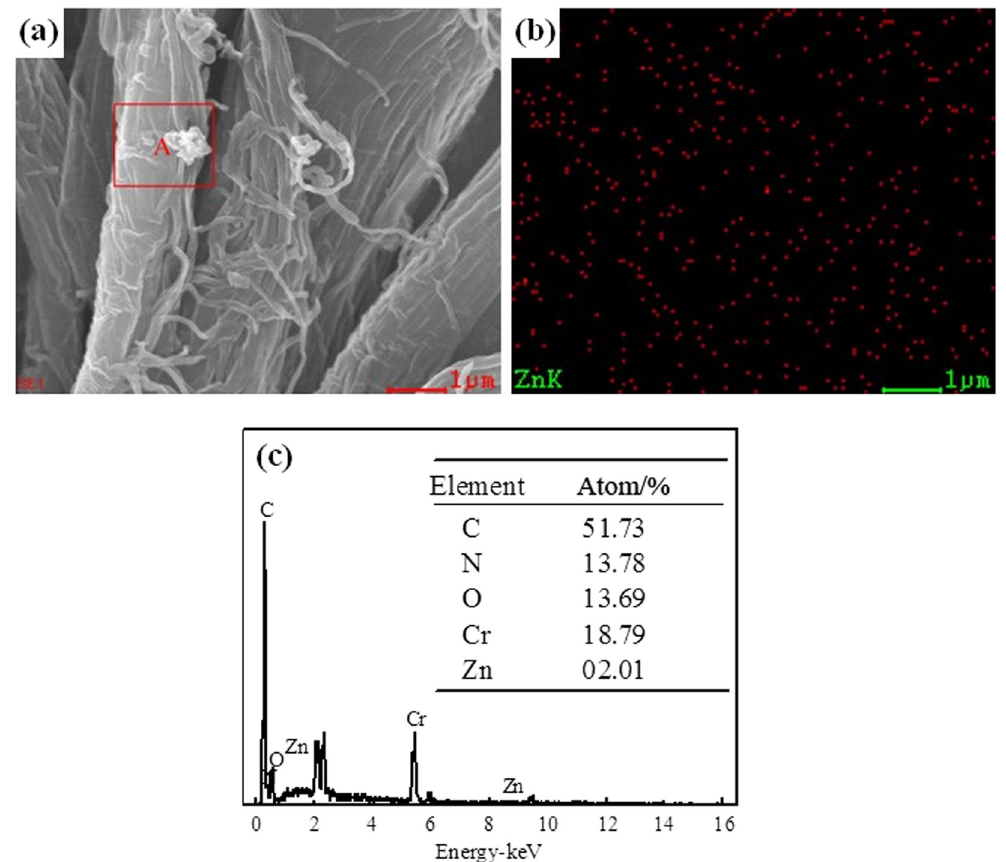
Figure 11. SEM-EDS of cross-section leather fatliquored by MHCO/GPTMS-ZnO